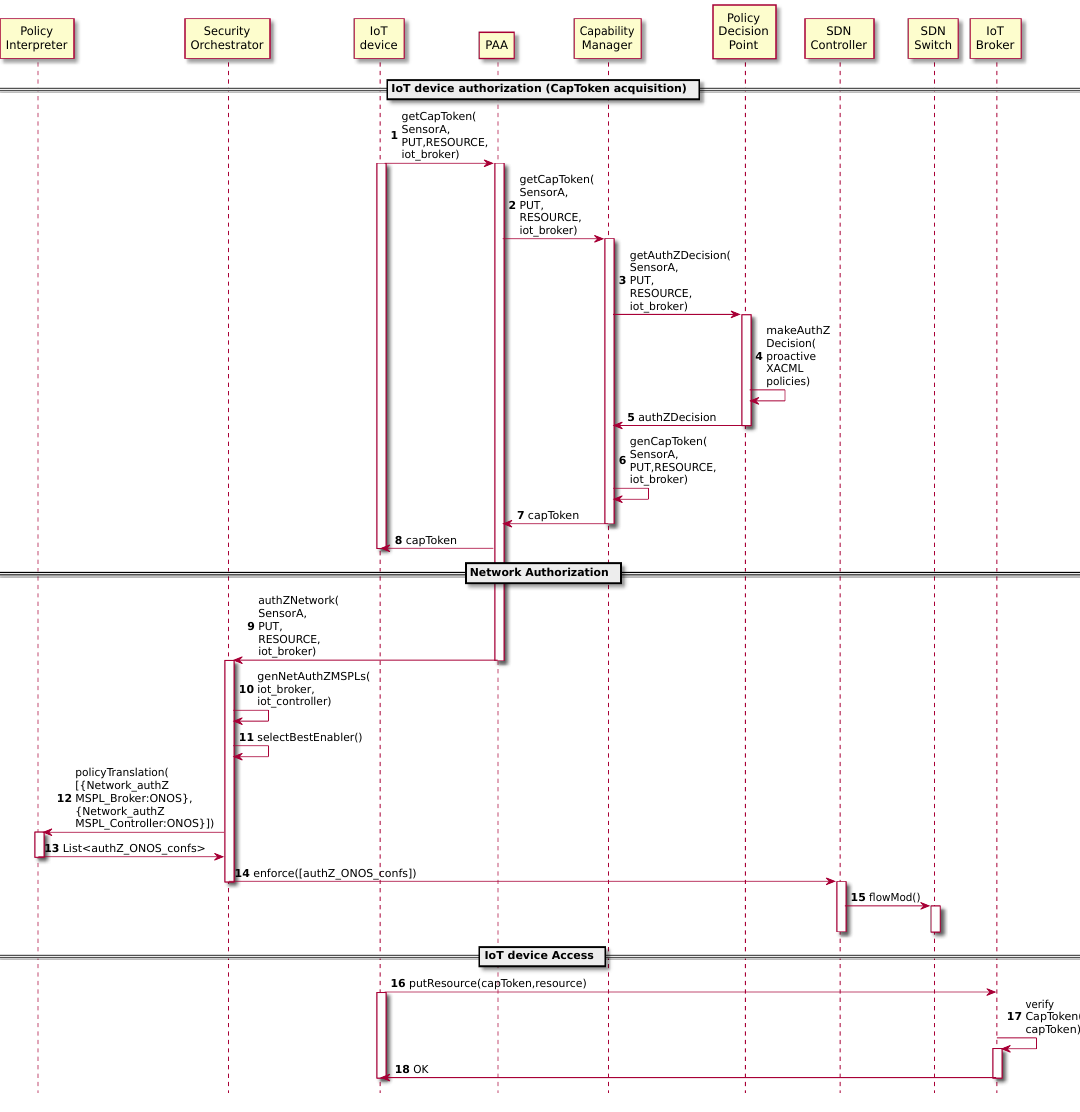
Figure 5. Authorization